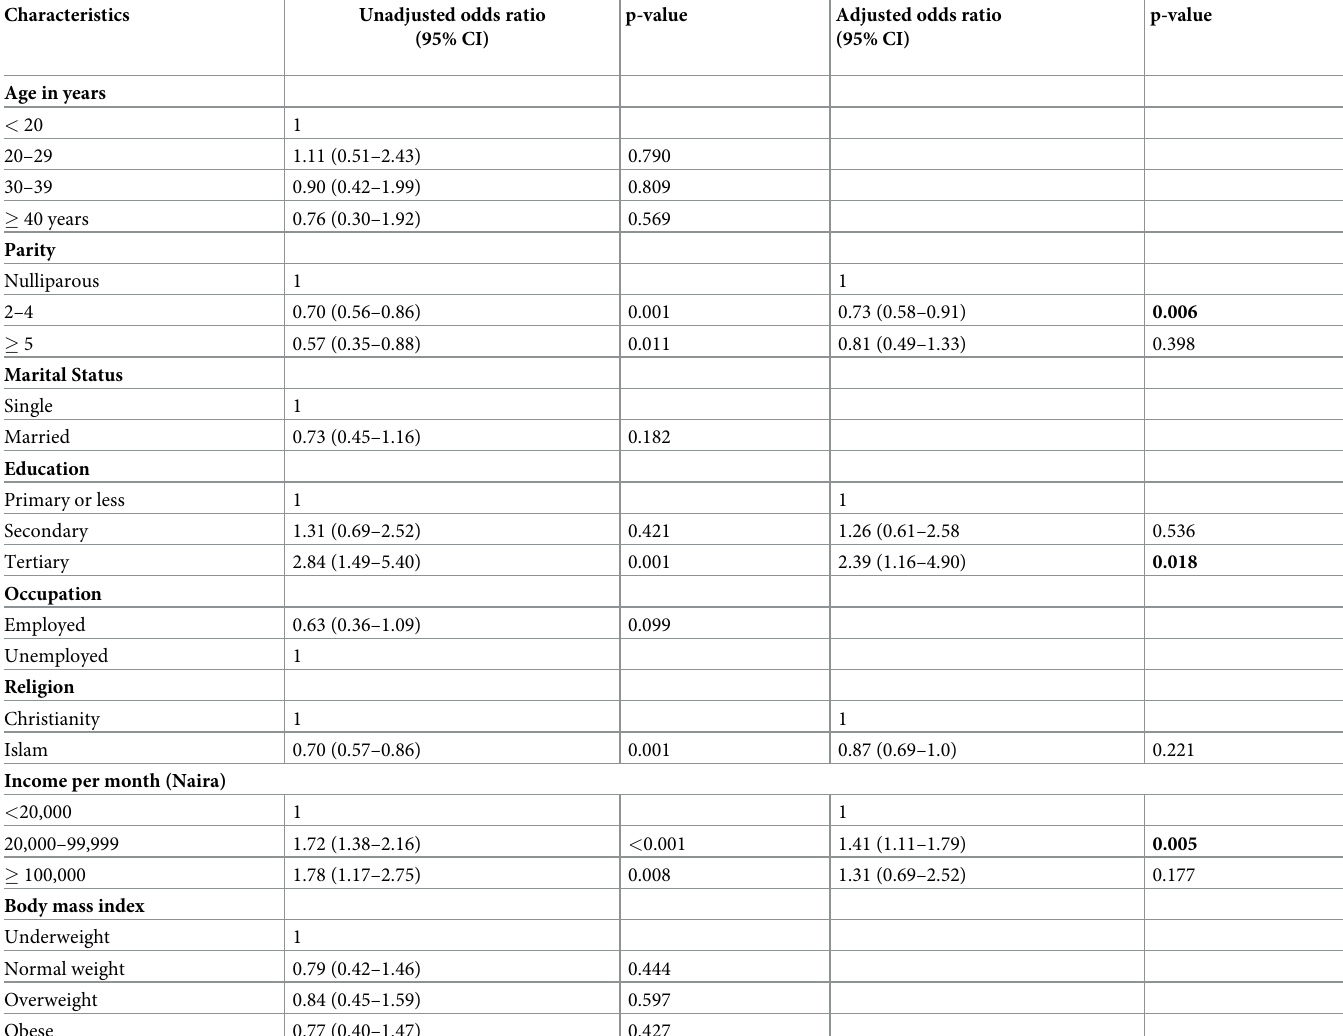
Table 3. Factors associated with sedentary behaviour among pregnant women in Ibadan.